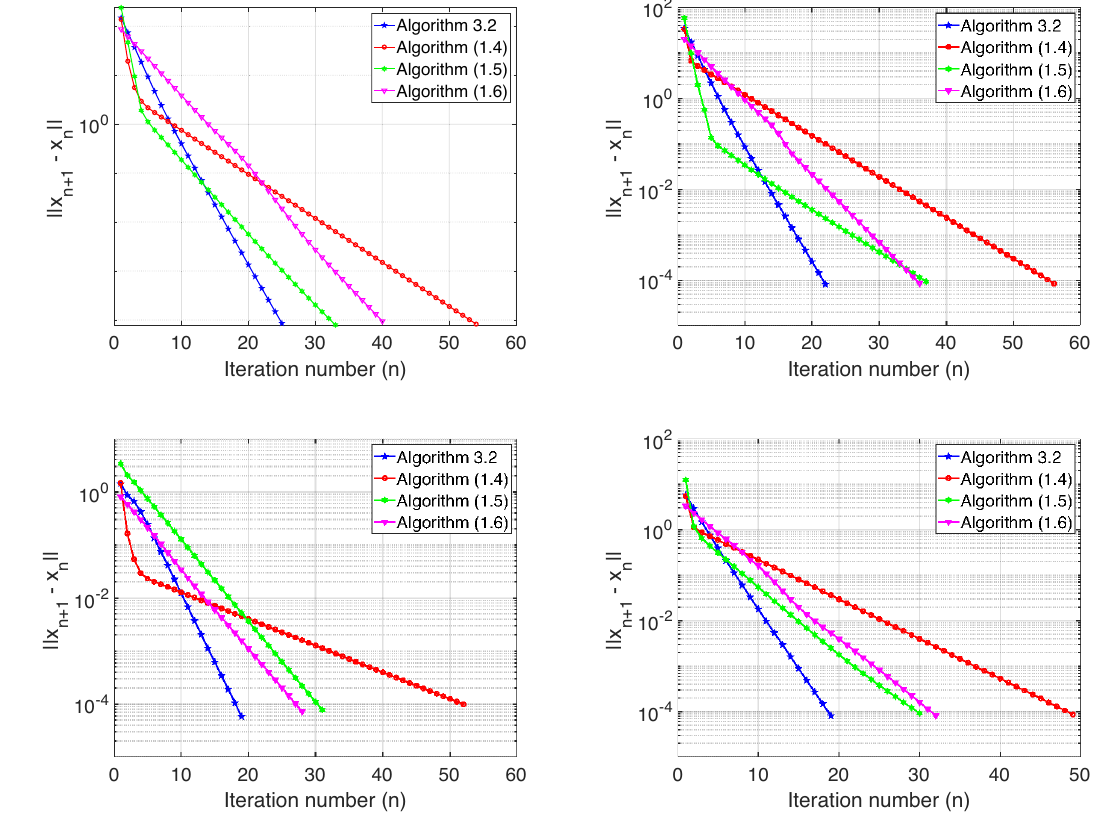
Algorithm 3.2 Algorithm (1.4)